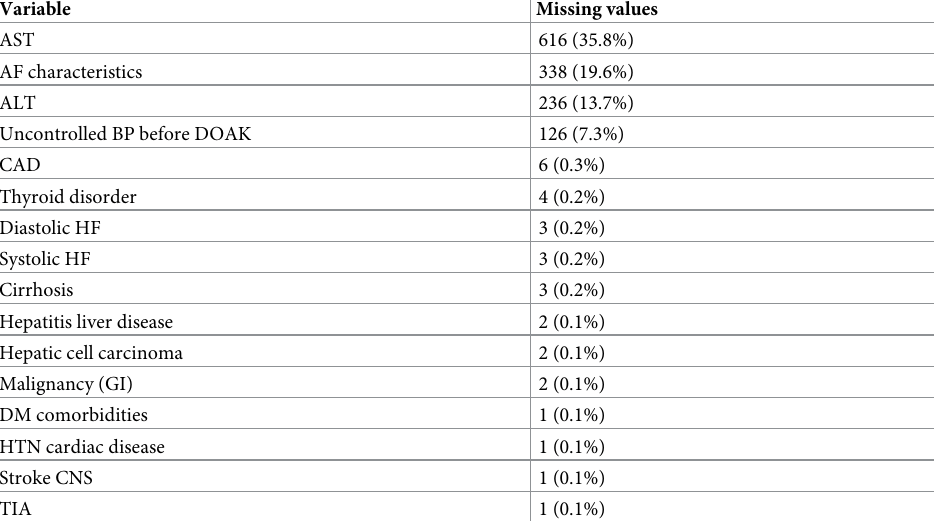
Table 3. Missing values.